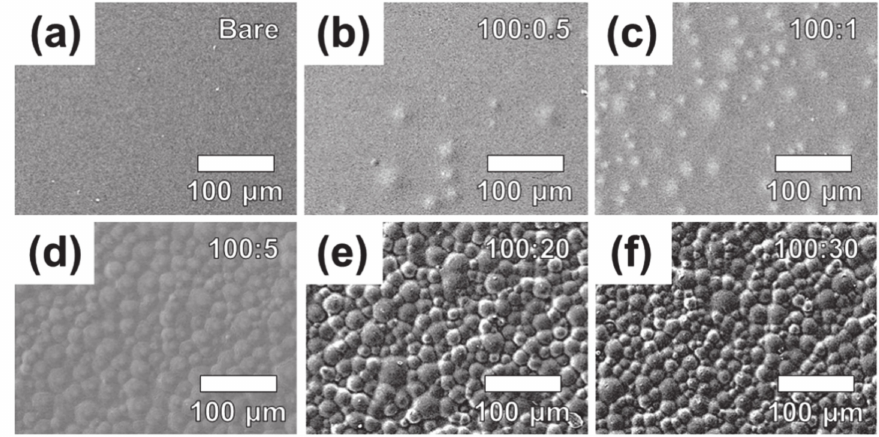
Figure 2. SEM images of the specimen surfaces with respect to PDMS:GB mixing ratio: ( a ) bare, ( b ) 100:0.5, ( c ) 100:1, ( d ) 100:5, ( e ) 100:20, and ( f )